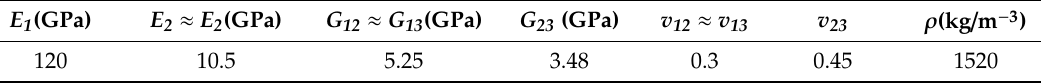
Table 2. Mechanical properties of CFRP.